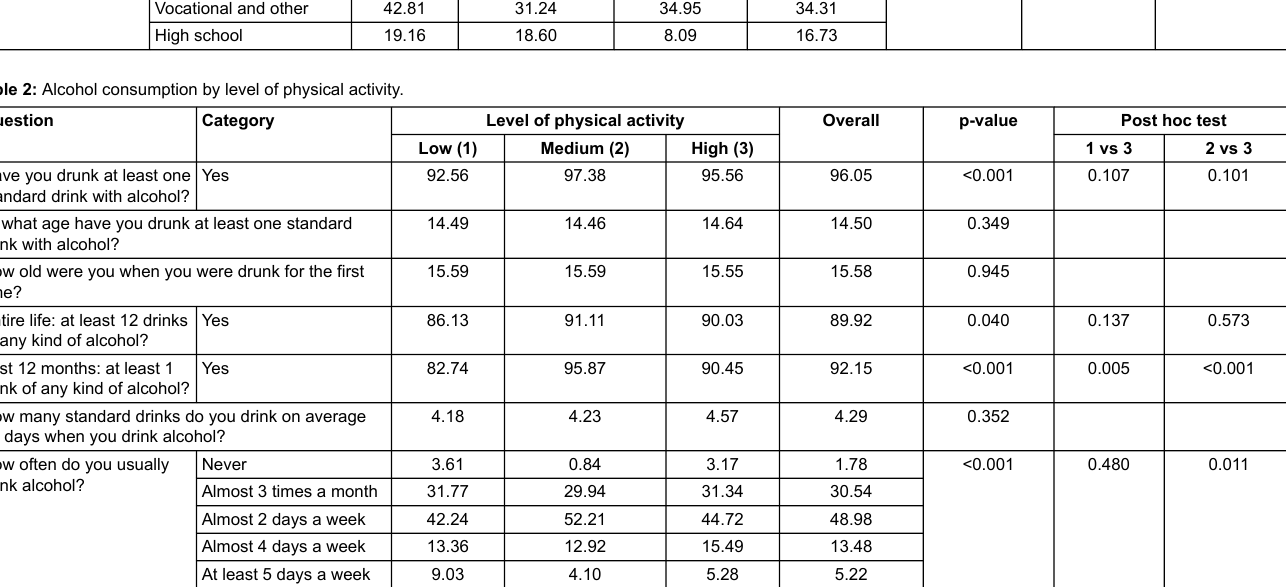
Table 2: Alcohol consumption by level of physical activity.